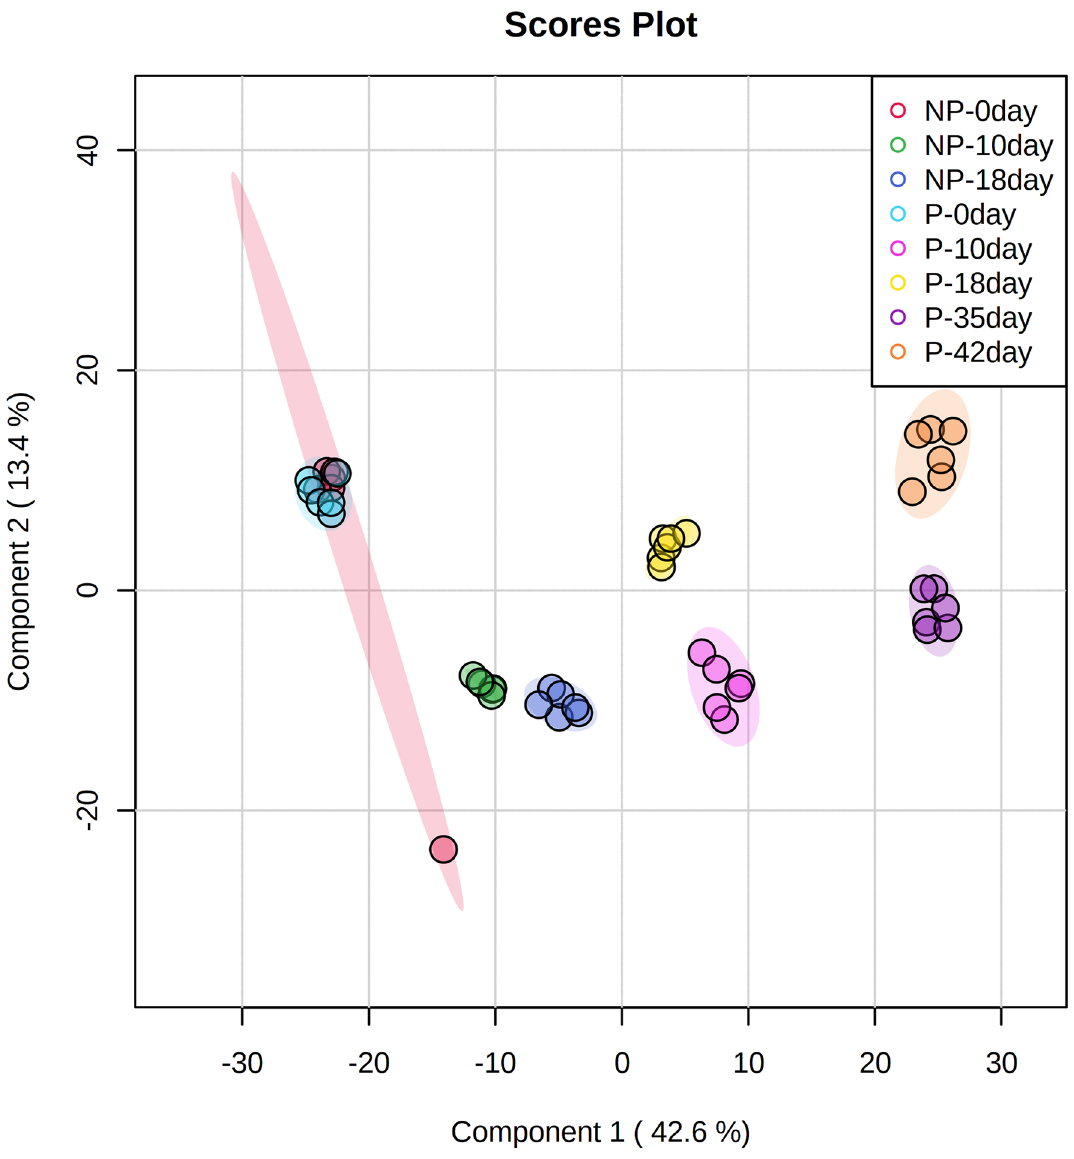
Figure 2. The 2D score plot of PLS-DA analysis incorporating Component 1 (42.6%) and Component 2 (13.4%) depicting prominent separate clusters of inter-group as well as inter-day variations except at day